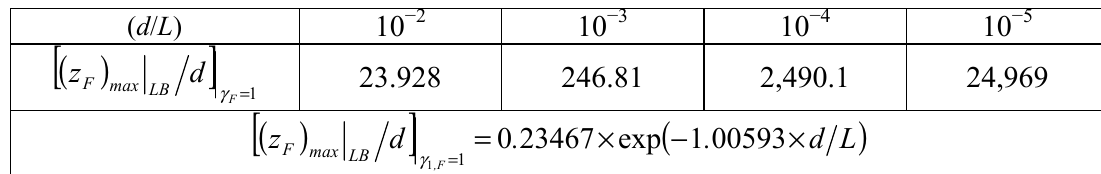
Table 1. Maximum value of rectangular microcantilever with long-slit side beams deflection that produces detection enhancement indicator due to concentrated force loading larger than